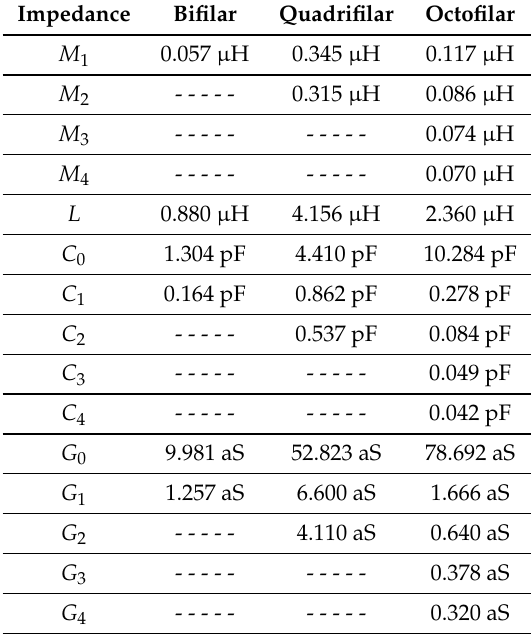
Table 2. Parasitic impedances values of bifilar, quadrifilar and octofilar CRs. Impedance Bifilar